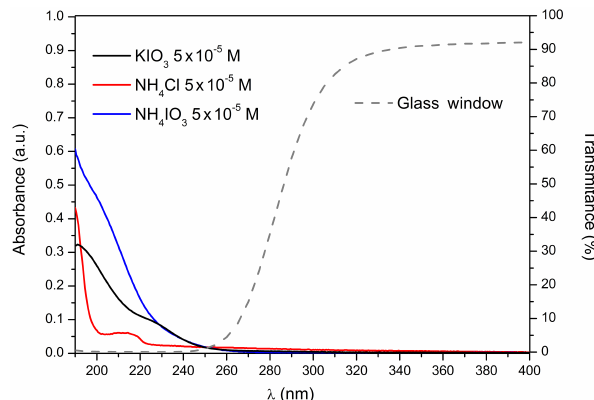
Figure 2. UV–Vis absorption spectra from 190 to 400nm for KIO 3 , NH 4 Cl and NH 4 IO 3 aqueous solutions (in absorbance unit) and the glass window present during irradiation (in %